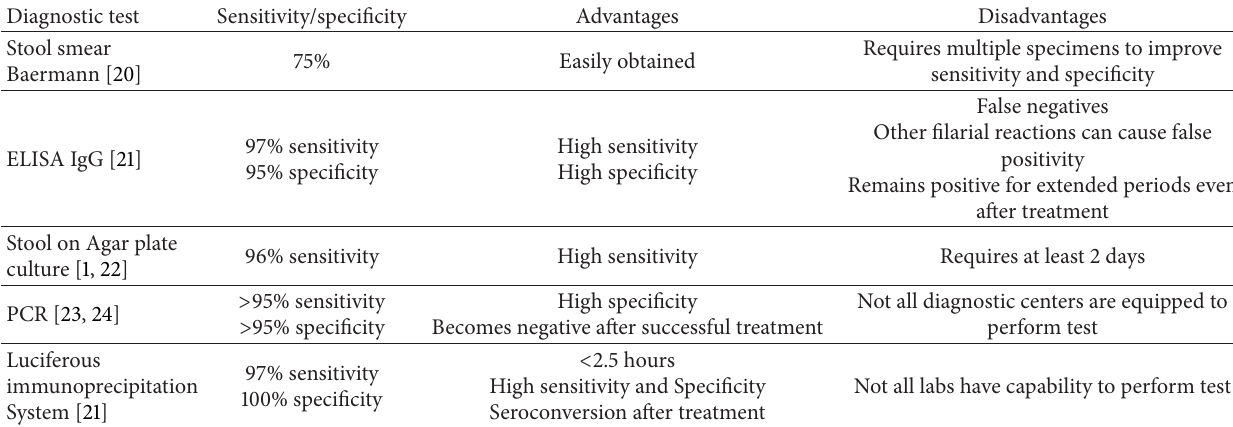
Table 4: Currently available strongyloides diagnostic